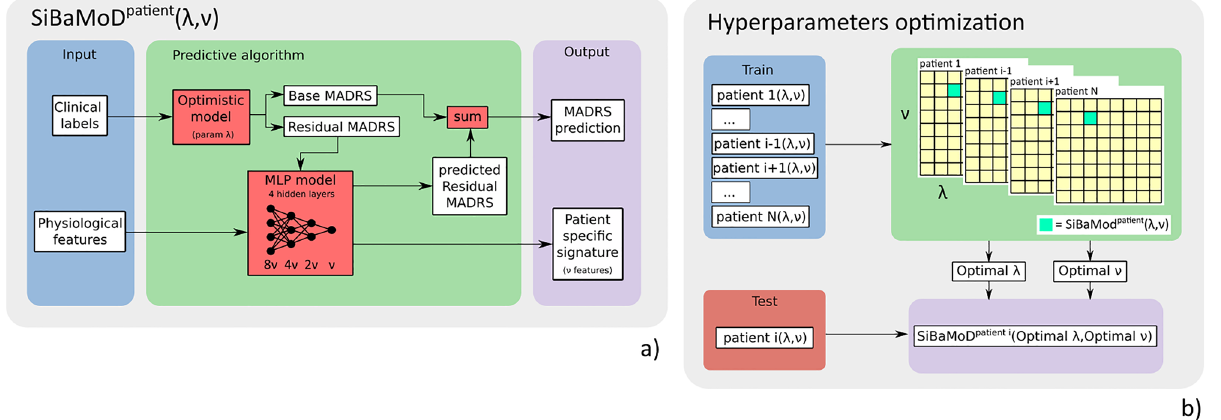
Figure 2. Overview of the full algorithm’s pipeline presented in this work. ( a ) The SiBaMoD pipeline with parameters ( λ , ν ) for a single given patient. The physiological features are used to train a multi-layer perceptron model, along with the training labels, which were detrended using the optimistic model with recovery rate λ . The prediction output of the model is then combined with the observed MADRS score to determine the predicted MADRS score. The ν features used by the model that are best correlated with the MADRS score form the patient specific signature. ( b ) In our cohort, the SiBaMoD pipeline is repeated using every patient as a test patient in a leave one patient out (LOPO) procedure, estimating the hyperparameters ( λ , ν ) for all patients except the test patient to determine the optimal values for these